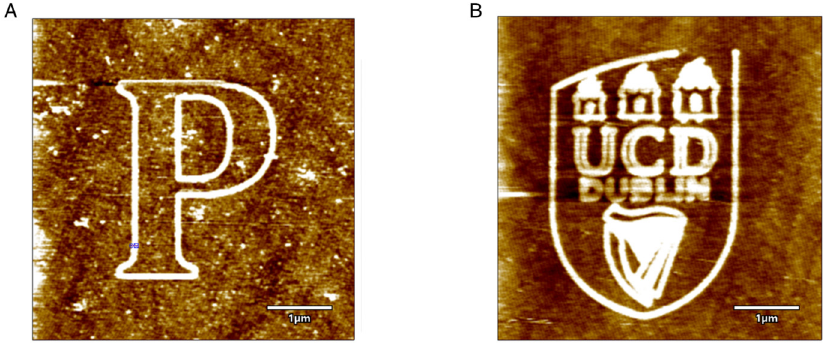
Figure 4. The intrinsic patterns fabricated over silicon substrate: ( A ) Letter ‘P’, and ( B ) UCD logo. F T = 0.1 μ N and tip bias of 7V, RH = 75%, V T = 1 μ m/s.